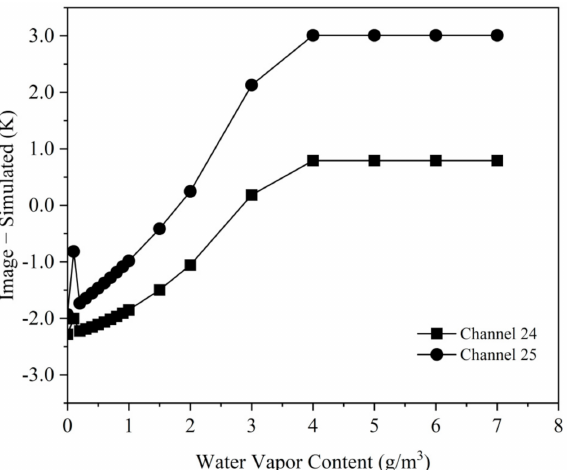
Figure 10. Sensitivity analysis for the variation of the brightness temperature bias induced by water vapor content using the MODTRAN